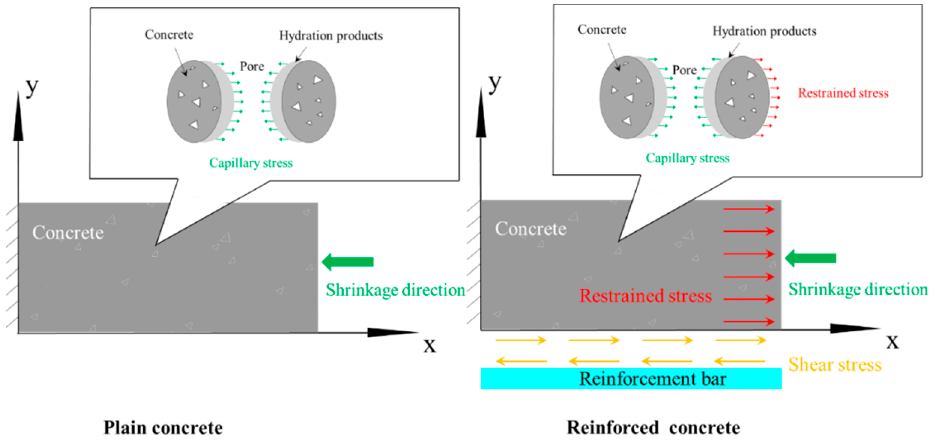
Figure 4. Changes in concrete pore structure.